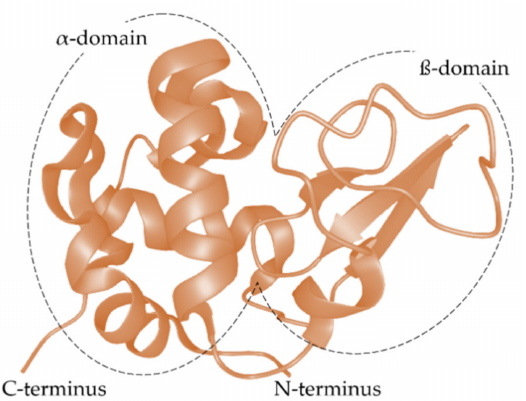
Figure 2. Ribbon model of the conformational structure of bovine α -lactalbumin (PDB ID 1F66S), redrawn from